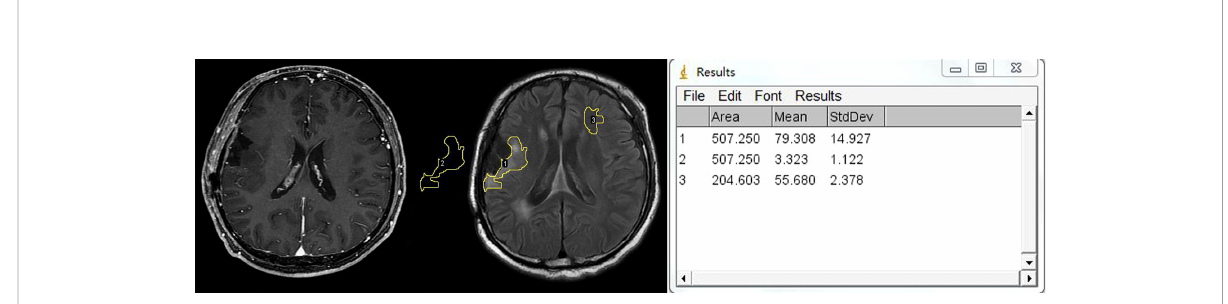
FIGURE 2 Example of region of interest (ROI) placement. Left fi gure: CE-T1WI shows no enhancement surrounding the residual cavity. Middle fi gure shows that three ROIs are placed in the hyperintensity lesion surrounding the residual cavity, contralateral white matter, and background of the image separately. Right fi gure shows the measurement output of Image